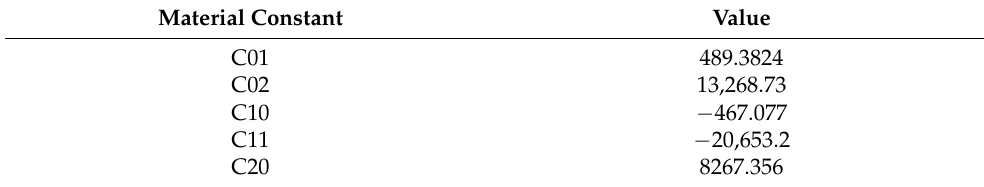
Figure 8. Curve fitting based on experimental tensile test. Table 3. Material constants for Mooney–Rivlin 5 Parameter (Equation (6)).